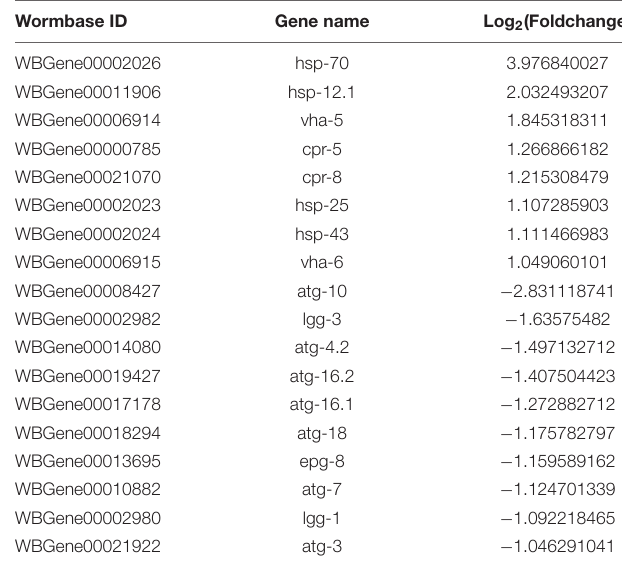
TABLE 4 | Autophagy-related gene expression after 24 h A β